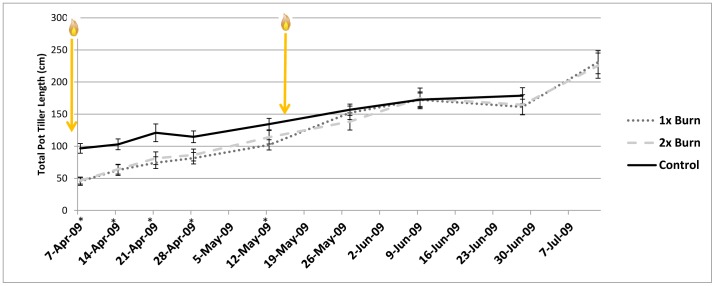
Average total pot tiller length (±1 S.E.) across the duration of the experiment, as measured at each of nine measurement intervals (measurements for all treatments were made within a two-day window for each interval).Asterisks indicate dates for which there was a significant difference between treatment means. Flame symbols indicate when the two prescribed burn treatments were applied to either both the 1x and 2x treatments for the first burn (25 March), or the 2x treatment only for the second burn (12 May).